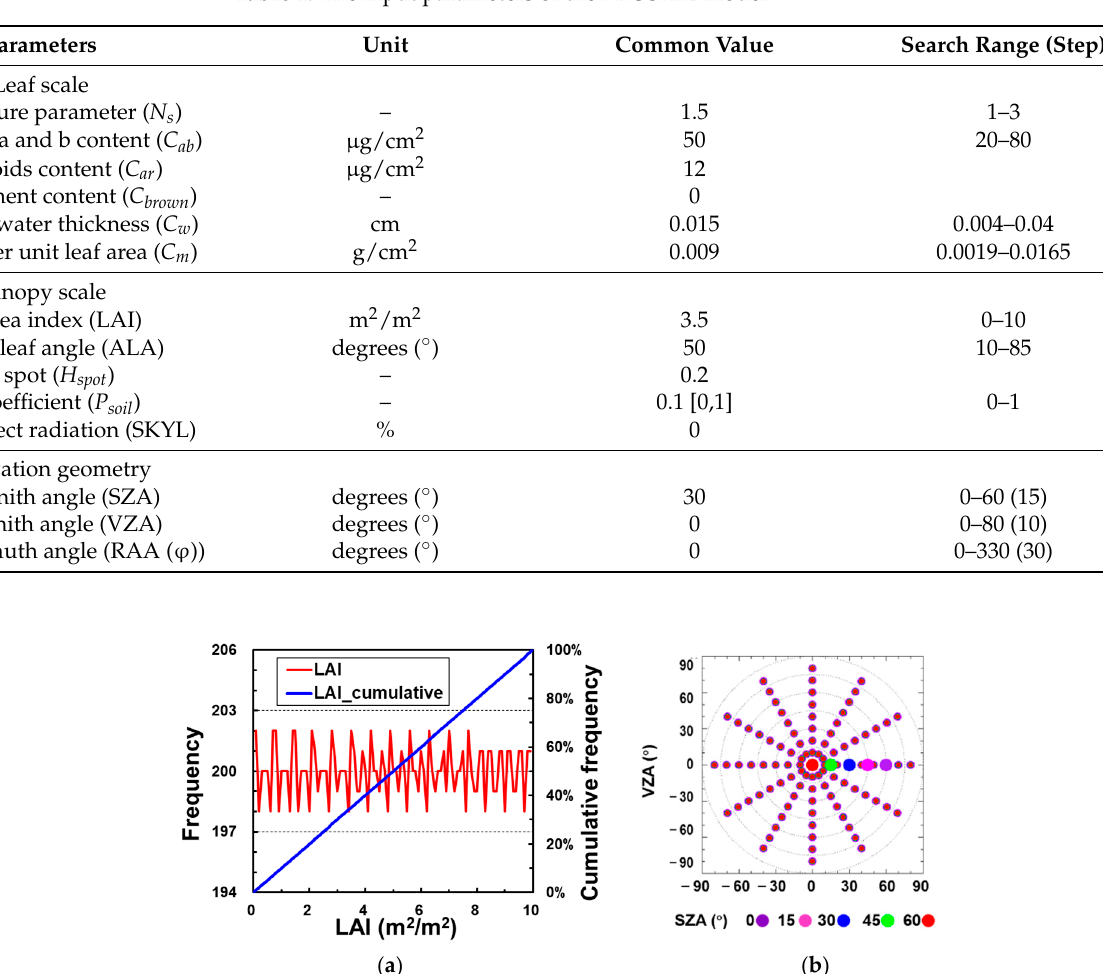
Table 1. The input parameters of the PROSAIL model.